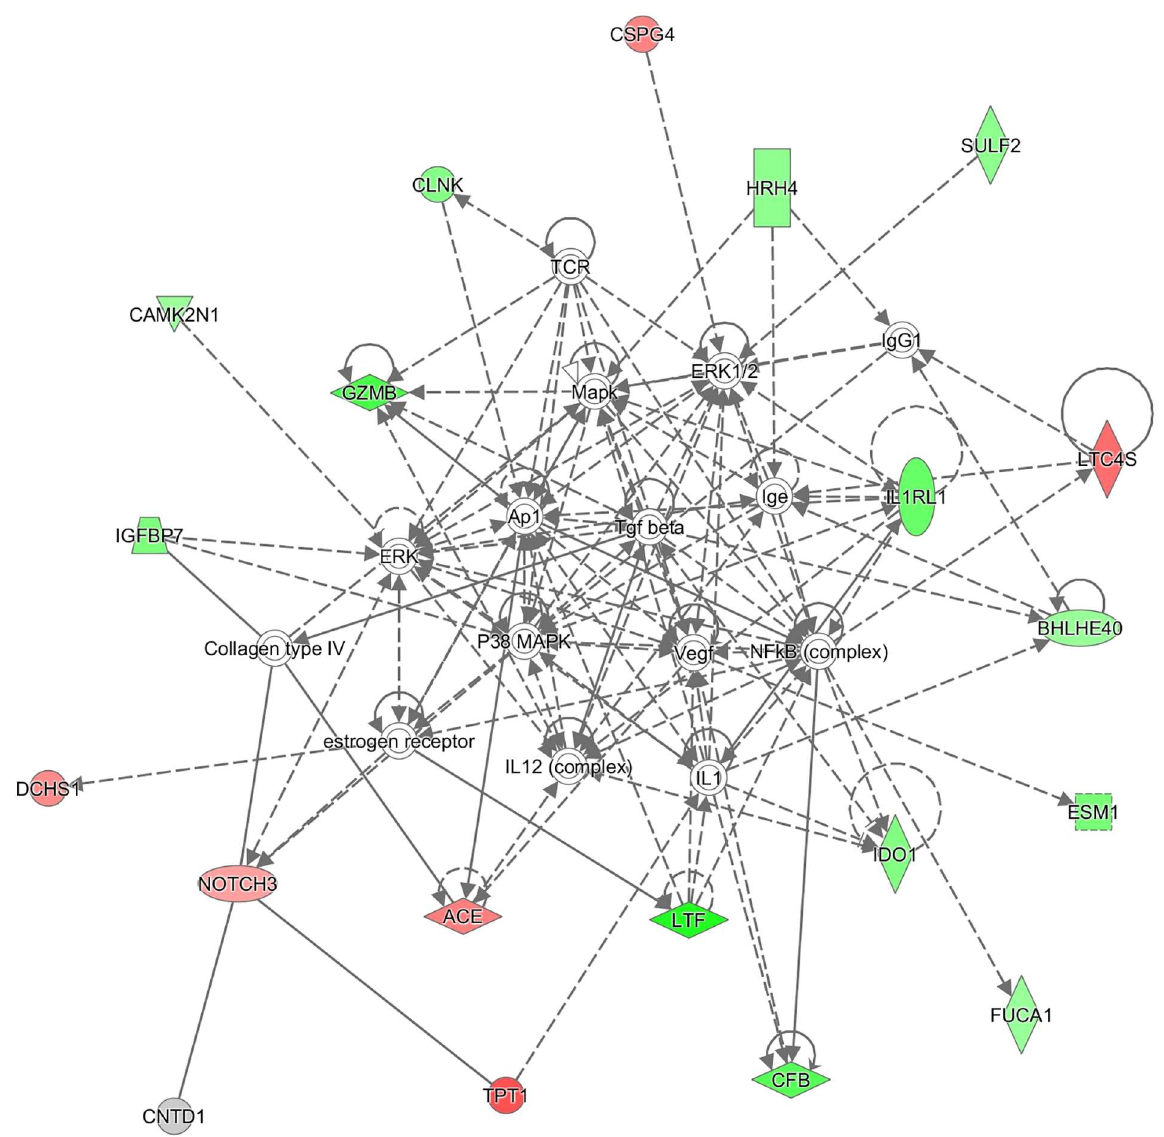
Fig 4. The most relevant network associated with DE genes of NP vs NN comparison. Up-regulated (pink) and down-regulated (green) genes involvedin lipid metabolism, small moleculesbiochemistry and Inflammatory response functions. Different shapes indicate different function of gene products: squares for cytokines, horizontalrectanglesfor ligand-dependentnuclear receptor, vertical rectangles for G-protein coupled receptors, vertical rhombus for enzymes, horizontalrhombus for peptidase, triangles for phosphatase, inverted triangle for kinase, vertical ovals for transmembrane receptors, horizontal ovals for transcription regulators, trapezius for transporters, doublecircles for complexes and circles for others.